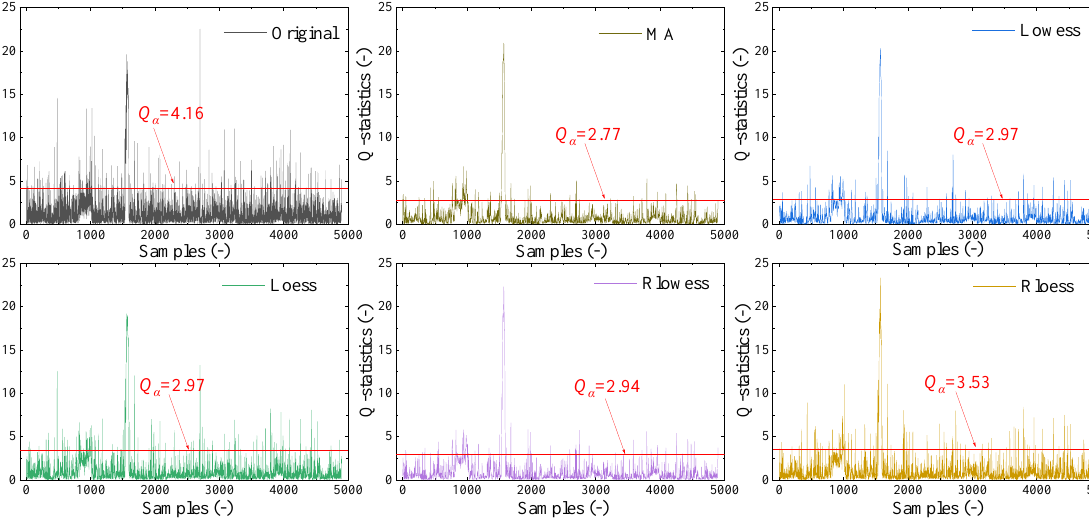
Figure 5. Data quality optimization performance of the MA method with different parameter settings.